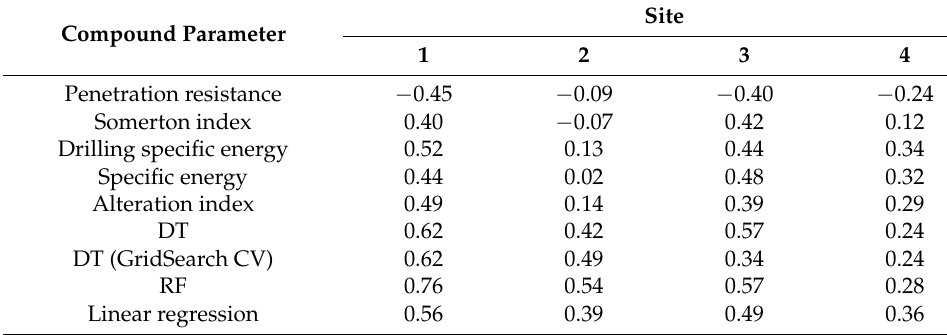
Table 12. Correlation coefficient for the compound parameters.